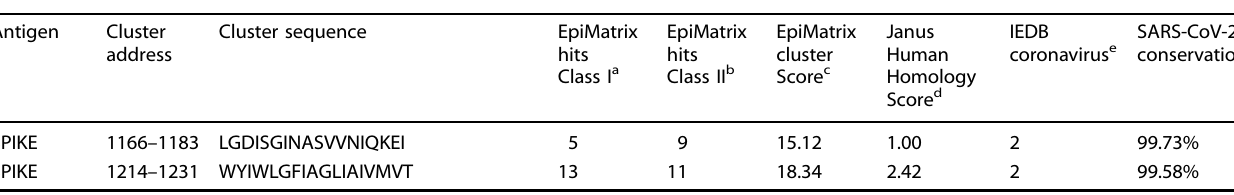
Table 2. Coronavirus cross-conservation features of effector T-cell epitope peptides screened in immunoassays.